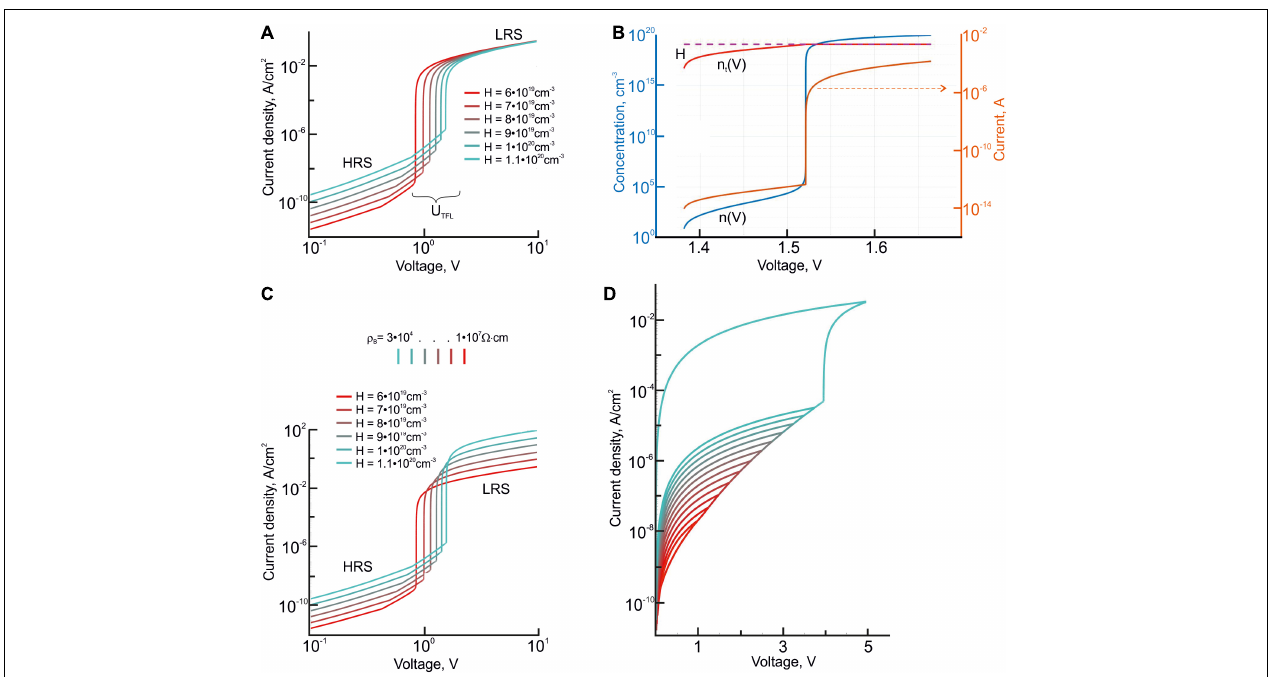
FIGURE 3 | (A) I-V characteristics of the TiO 2 /Al 2 O 3 bilayer structures with different concentrations of the trap centers H in the aluminum oxide layer. The trapping parameters were taken in accordance with (Perevalov, 2015): for H = 6 · 10 19 cm 3 , hopping transport activation energy E a 0 = 1 . 9 eV and E C − E t = 1 . 7 eV ; for H = 7 · 10 19 cm 3 - E a 0 = 1 . 86 eV and E C − E t = 1 . 74 eV ; H = 8 · 10 19 cm 3 , E a 0 = 1 . 82 eV , E C − E t = 1 . 78 eV ; H = 9 · 10 19 cm 3 , E a 0 = 1 . 78 eV , E C − E t = 1 . 82 eV ; H = 1 · 10 20 cm 3 , E a 0 = 1 . 74 eV , E C − E t = 1 . 86 eV ; H = 1 . 1 · 10 20 cm 3 , E a 0 = 1 . 7 eV , E C − E t = 1 . 9 eV . (B) The dependence of the non-equilibrium concentrations of electrons captured by traps (n t ), non-equilibrium electron densities in the conduction band (n), and the current through the TiO 2 /Al 2 O 3 bilayer structure on the applied voltage. (C) I-V characteristics of the TiO 2 /Al 2 O 3 bilayer structures with different concentrations of the trap centers in the aluminum oxide layer. The resistance of the titanium oxide film, connected in series with the resistance of the active aluminum oxide film, varies in the range of 10 7 –3 × 10 4 (cid:127) · cm. (D) I-V characteristics of the TiO 2 /Al 2 O 3 bilayer structures with the concentration of the trap centers in the aluminum oxide layer being equal to 8 · 10 19 cm – 3 . The gradual resistance tuning is associated with increasing the amplitude of the voltage pulses applied to the structure in the range of 1–5